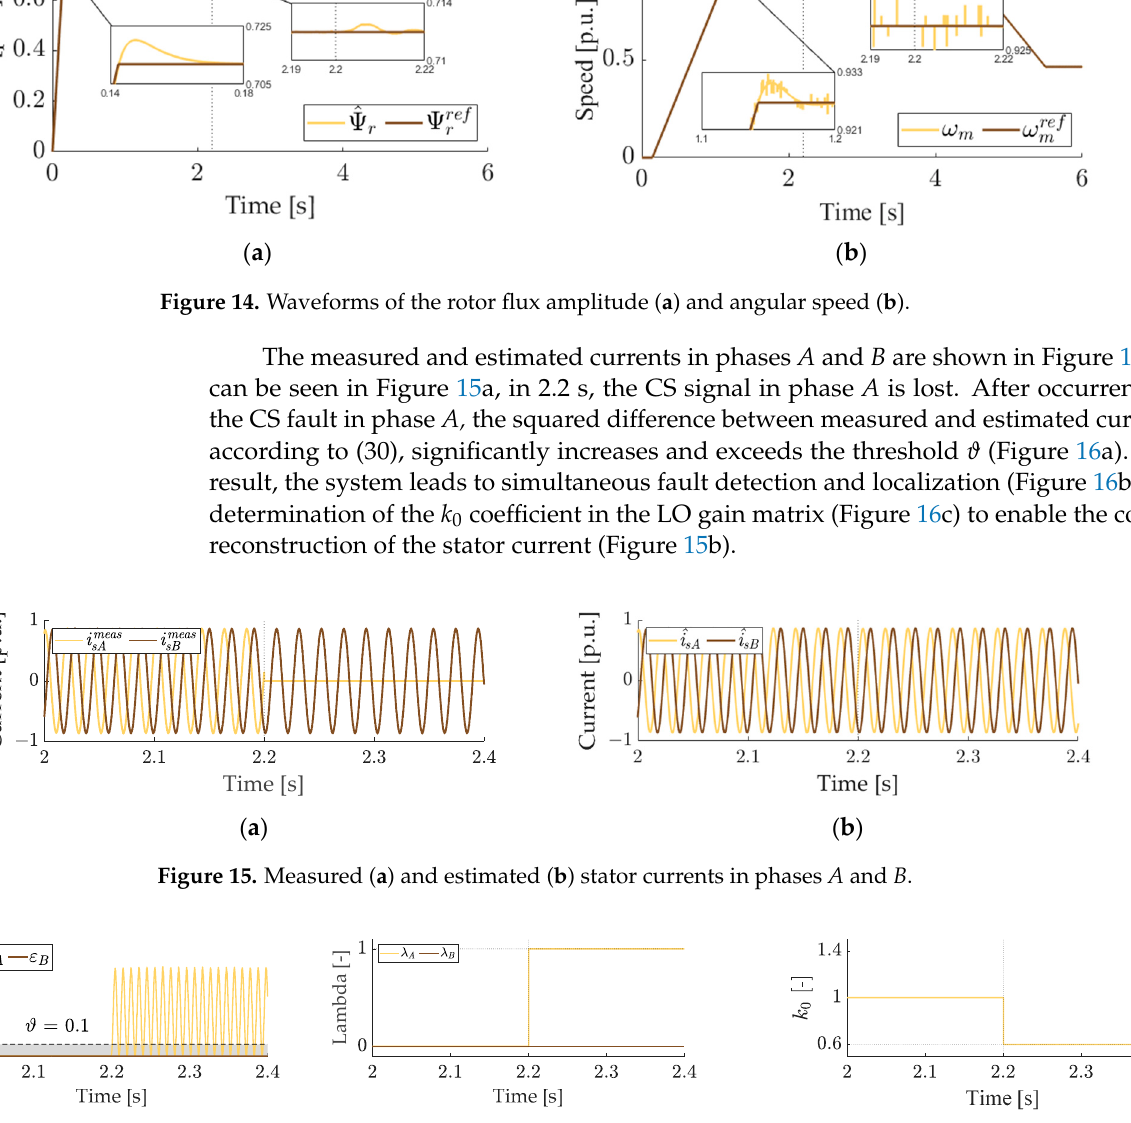
0 coefficient in G matrix ( c